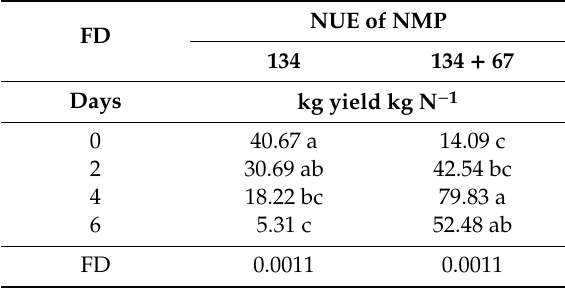
Table 5. Nitrogen use e ffi ciency (NUE) for each flood duration (FD). The NUE was measured as the yield gained per unit N applied over the previous level of nitrogen management practice (NMP) (yield gained by applying 134 kg N ha − 1 over 0 kg N ha − 1 or yield gained by applying 134 + 67 kg N ha − 1 over 134 kg N ha − 1 only). p values are presented within each column for FD. Di ff erent letters indicate di ff erences in means for each FD within each column.